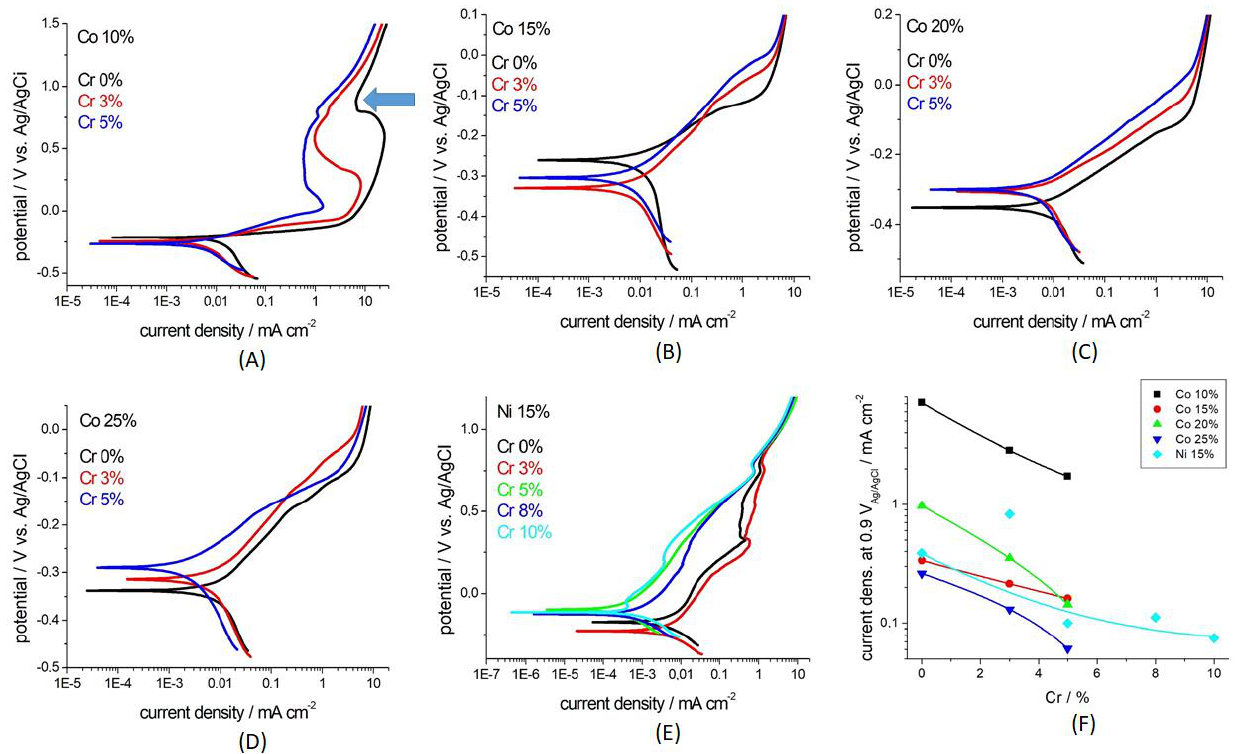
Figure 11. ( A – E ) LSV curves for the indicated Co- and Ni-base hard metal grades with Cr additions, in Na 2 SO 4 0.5 M aerated aqueous solution (scan rate: 1 mV s − 1 ). ( F ) The current density at 0.9 V Ag/AgCl for the investigated grade (i.e., the potential corresponding to the anodic end of the PP potential range of the Cr-free Co 10% grade, see grey arrow in Panel ( A